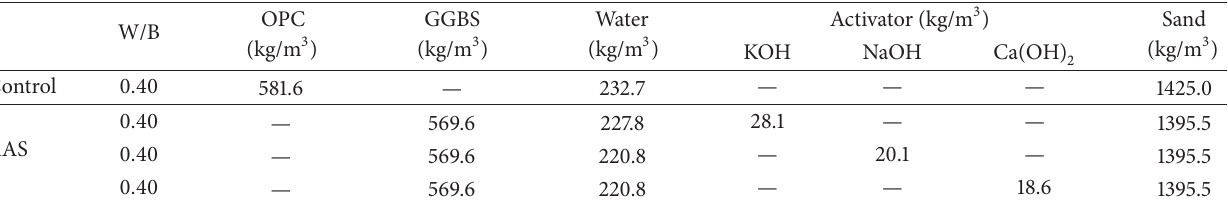
Table 2: Mix proportion for AAS mortar and control